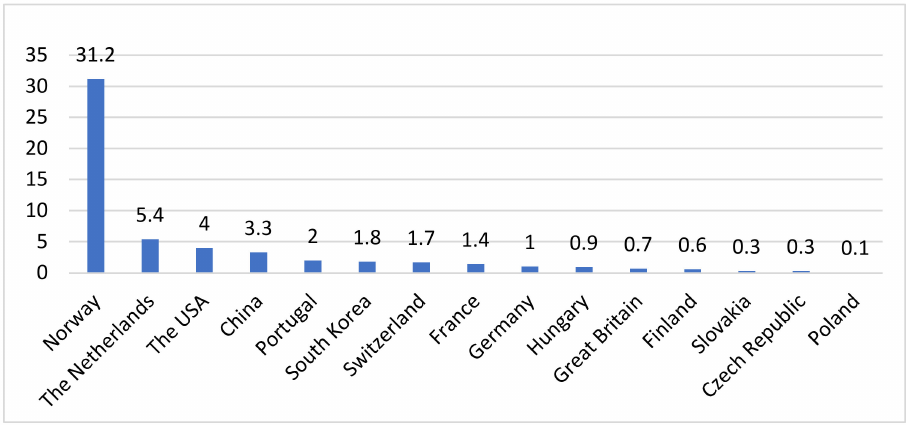
Figure 1. Percentage of registered electric cars among passenger cars in Poland and selected countries (2018, %) (reproduced from [9], p. 24, Polski Instytut